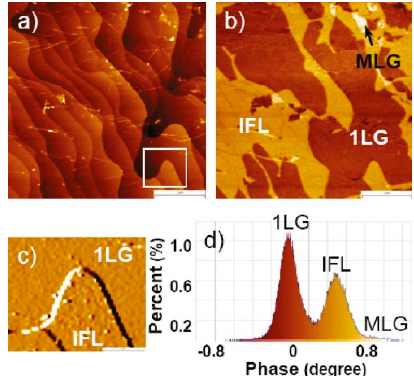
Figure 7. Typical area of epitaxial graphene on 4H-SiC(0001): ( a ) topography (z-range is 13 nm); ( b ) corresponding EFM phase image (z-range is 2 ° ); ( c ) topography deflection error signal highlighting the adsorbates found on the interfacial layer (IFL) compared to the clean 1LG; ( d ) histogram for the EFM phase image clearly showing 1LG (40% of the total area) and IFL areas. MLG constitutes less than 2% of the total area [58].